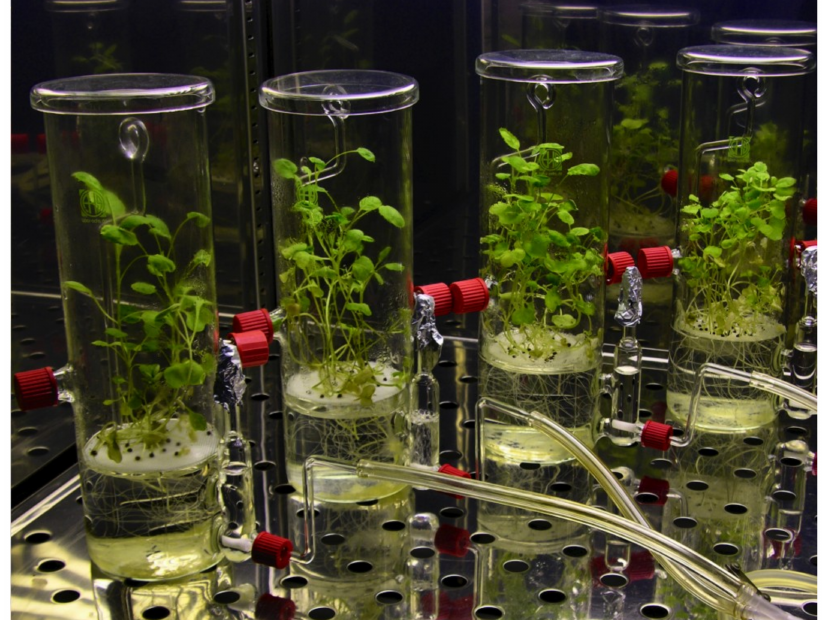
Figure 3. Oilseed rape ( Brassica napus L.) grown in sterile hydroponics. Ten plants per bioreactor were grown in 0.5 × MS medium for three weeks at 24 ◦ C with 12 h light per day. External light-shielding cylinders were removed for the